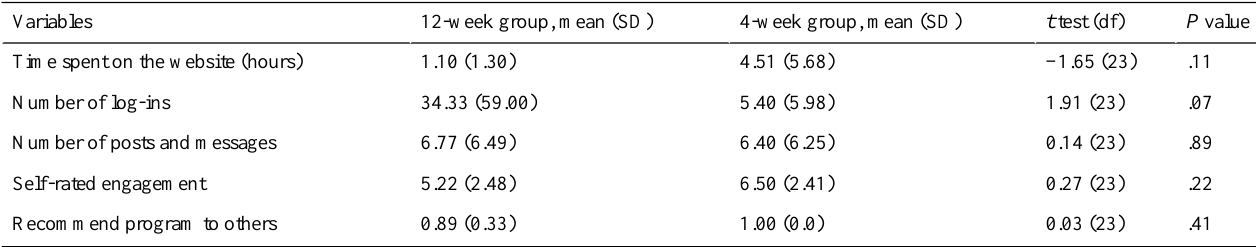
Table 2. Differences between 12- and 4-week formats ( t